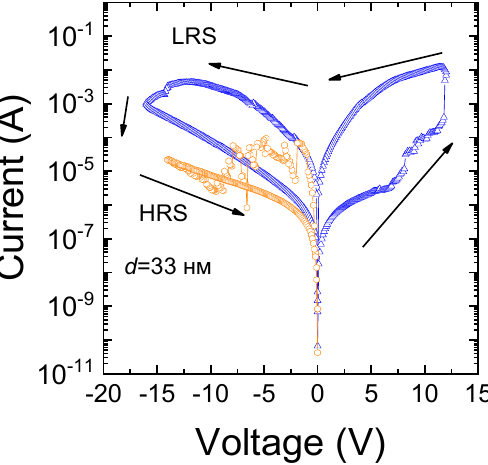
Figure 3. IV characteristics of the PECVD SiO 0.9 N 0.6 -based